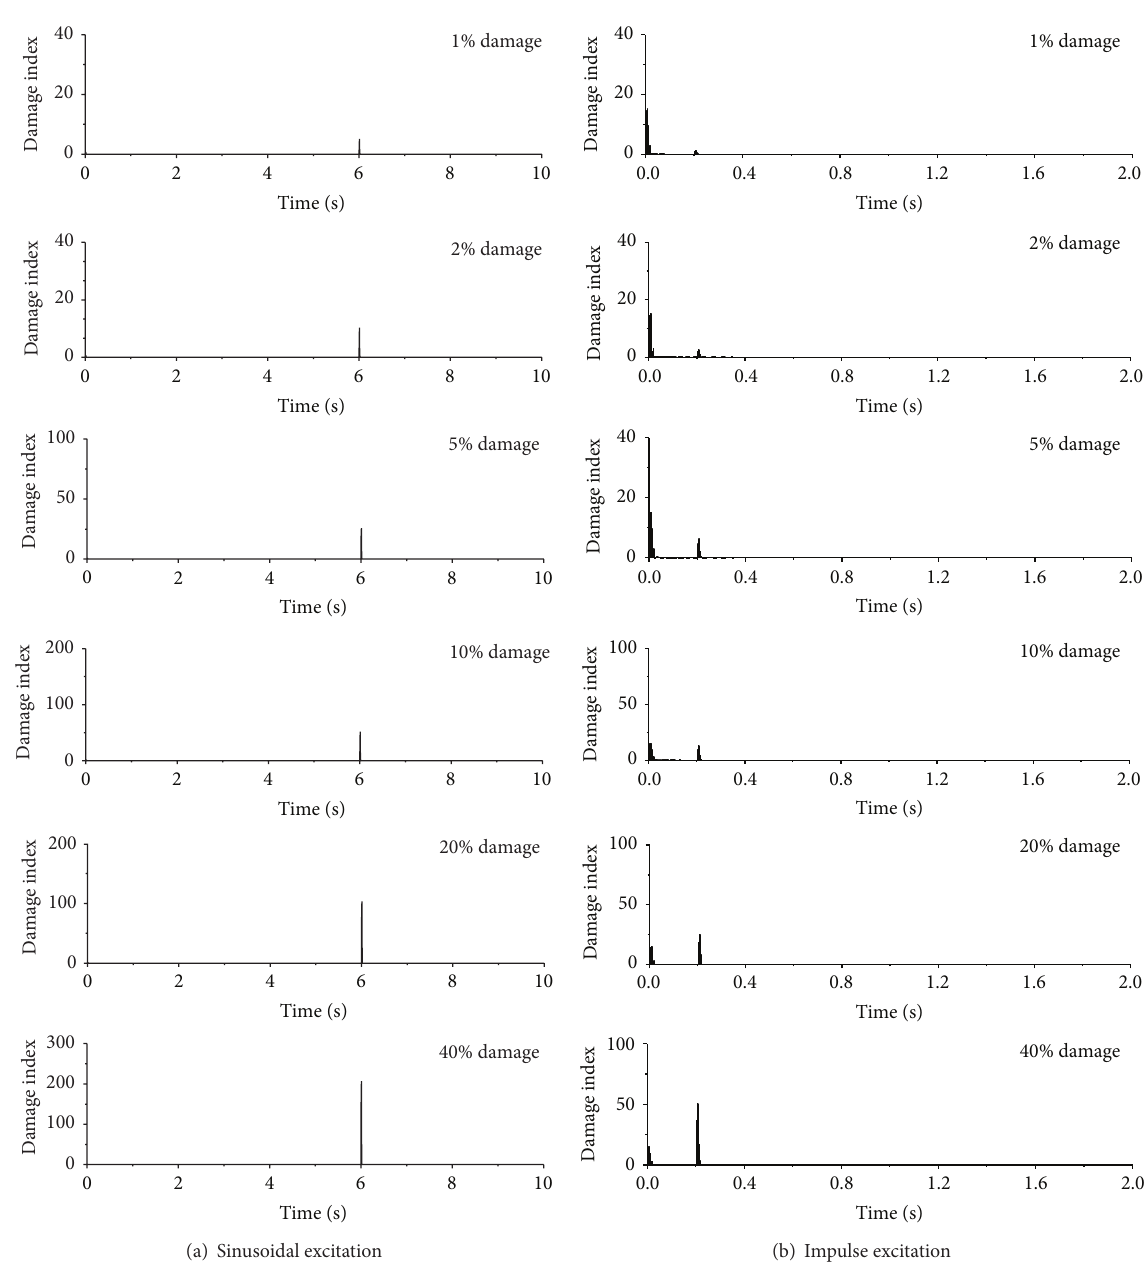
Figure 13: Damage detection using db4